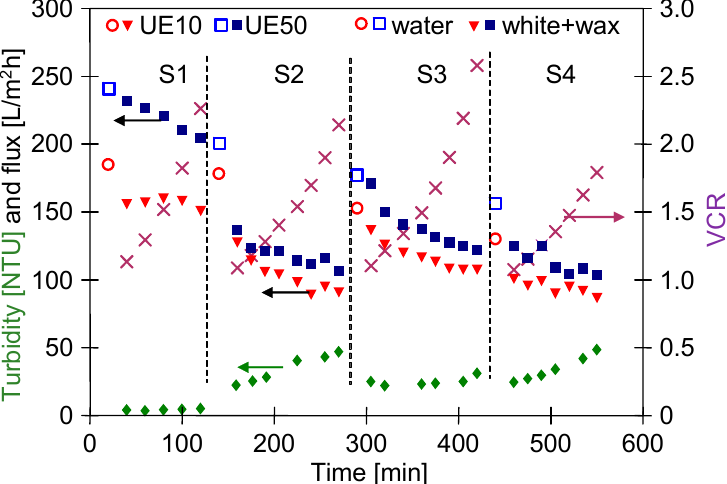
Figure 10. Changes in the feed turbidity, permeate flux and VCR during the UF process with continuous permeate collection. S1–S4—measurement series. Feed: S1—wax (0.2%) + white (0.5%), S2–S4: white (0.5%) + wax (0.2%). Feed flow rate: 1 m/s. Water—permeate flux after rinsing